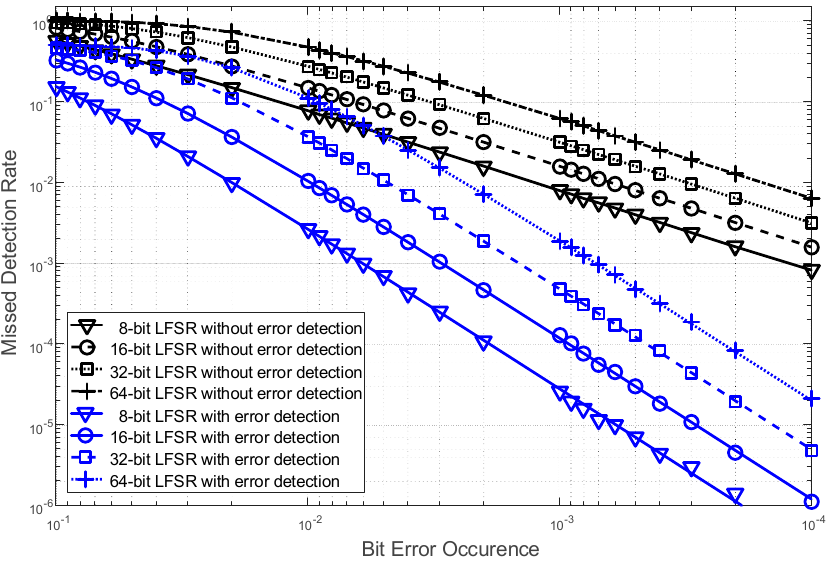
Figure 7 . Missed Detection Rates for the proposed FT-LFSR. Figure 7. Missed Detection Rates for the proposed